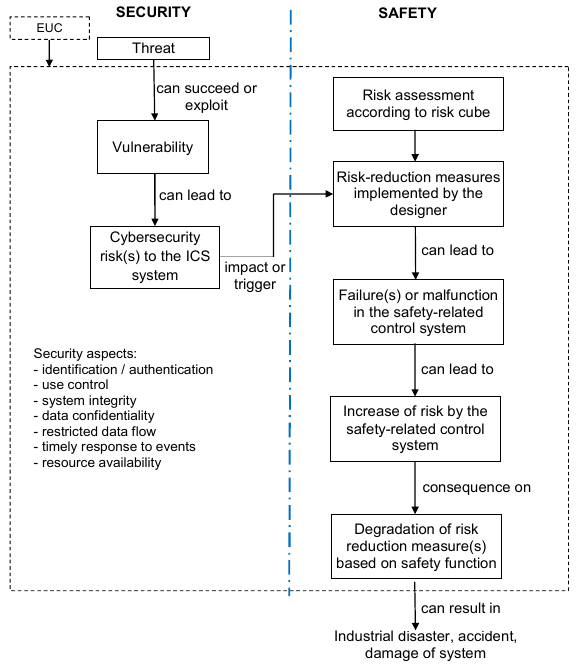
Figure 3. Relationship between functional safety and cybersecurity of ICS systems [19,20].